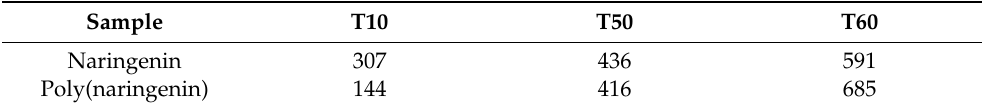
Table 1. Values of T10, T50, and T60 of naringenin and poly(naringenin). Standard deviation: temperature ± 0.7 ◦ C.